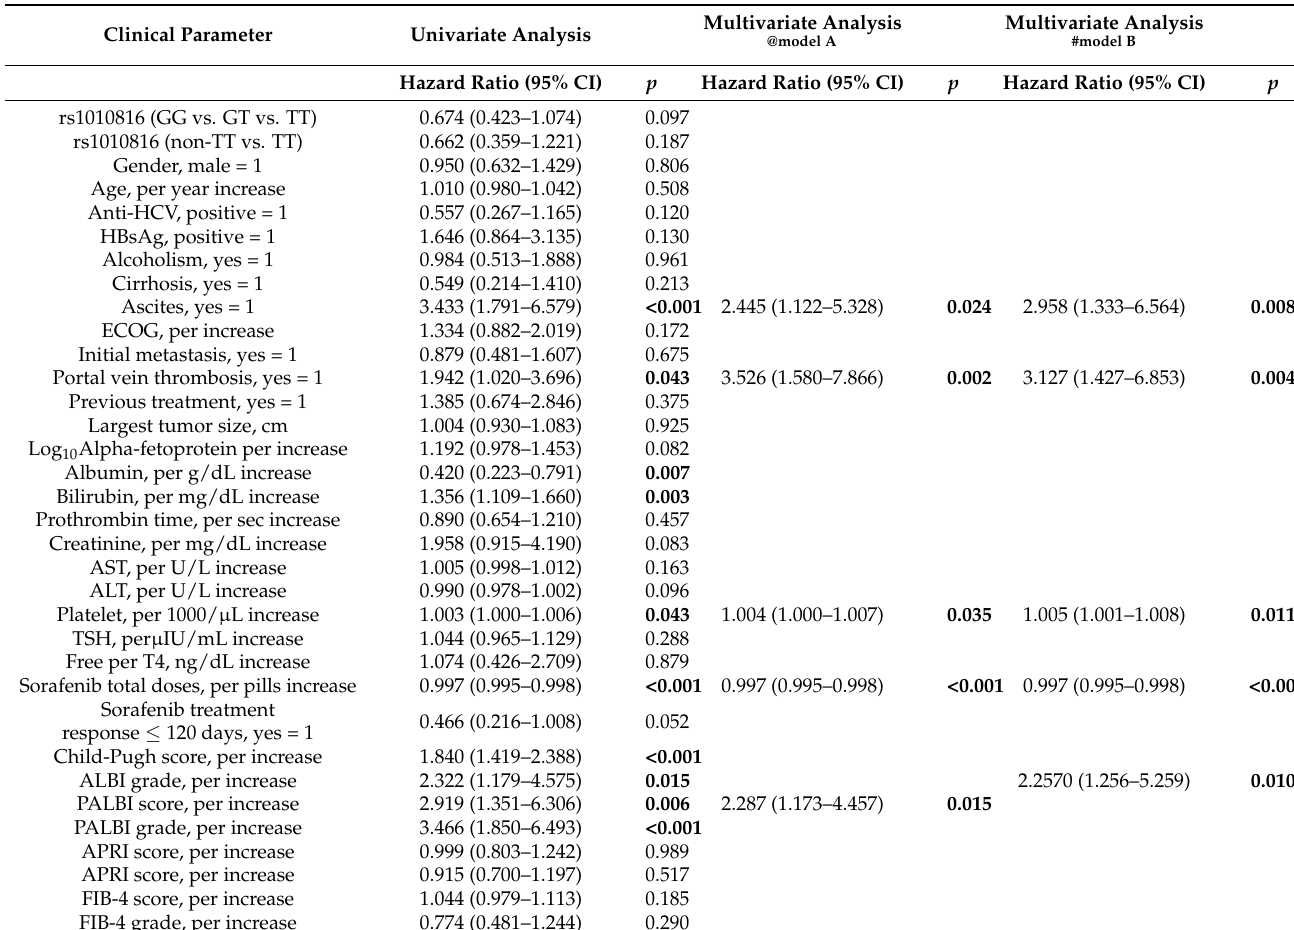
Table 4. Cox proportional hazard analysis for association between genetic and clinical factors and overall